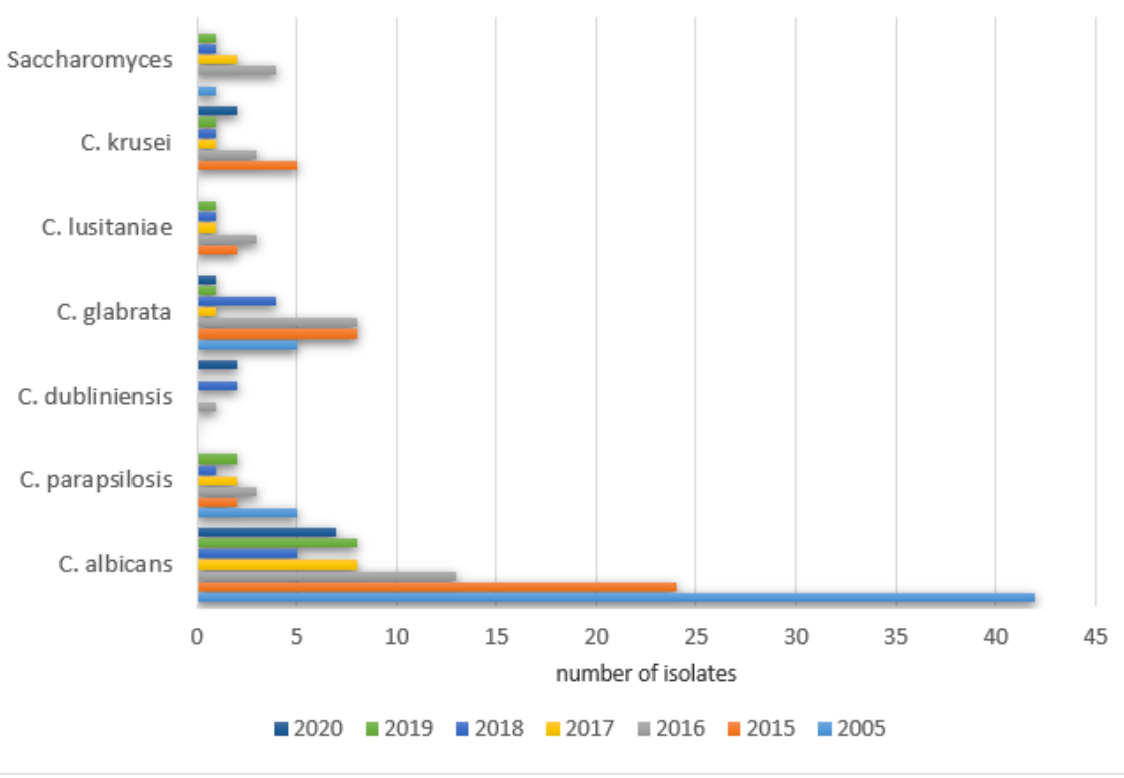
Figure 9. Yeast and Saccharomyces species isolated from gastrointestinal tract PCICU samples in the studied years.